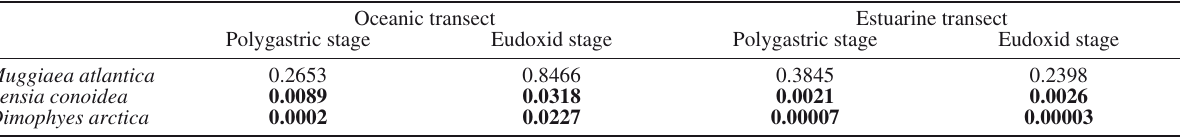
Table 3. – Kruskal-Wallis test for differences in abundances of polygastric and eudoxid stages of the dominant spe- cies between the three depth strata in both the oceanic and estuarine transects. Significant values are indicated in bold ( p <0.05).